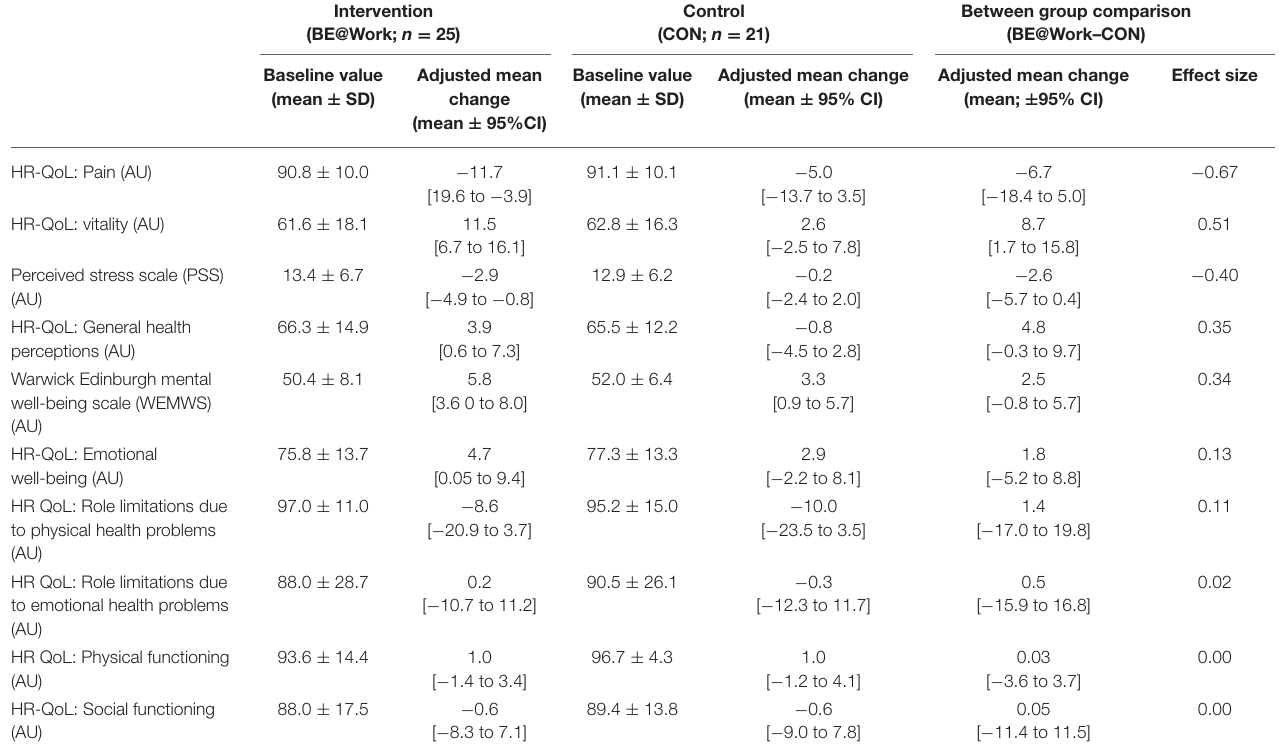
TABLE 6 | Intervention effect on mental well-being